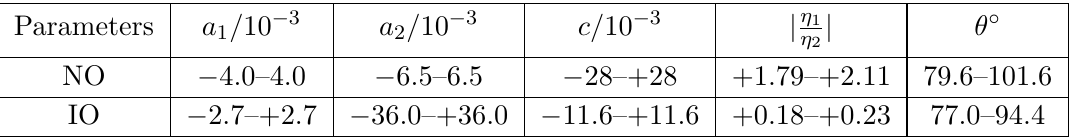
Table 2 . Output values of the parameters of M (cid:23)